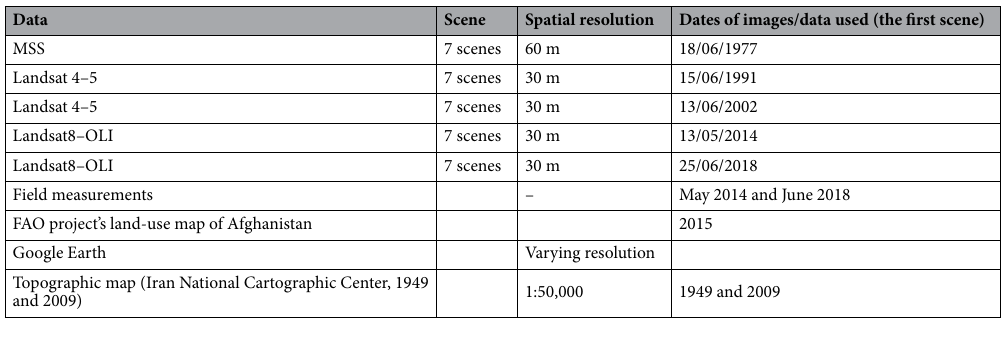
Table 3. Data used in this study.